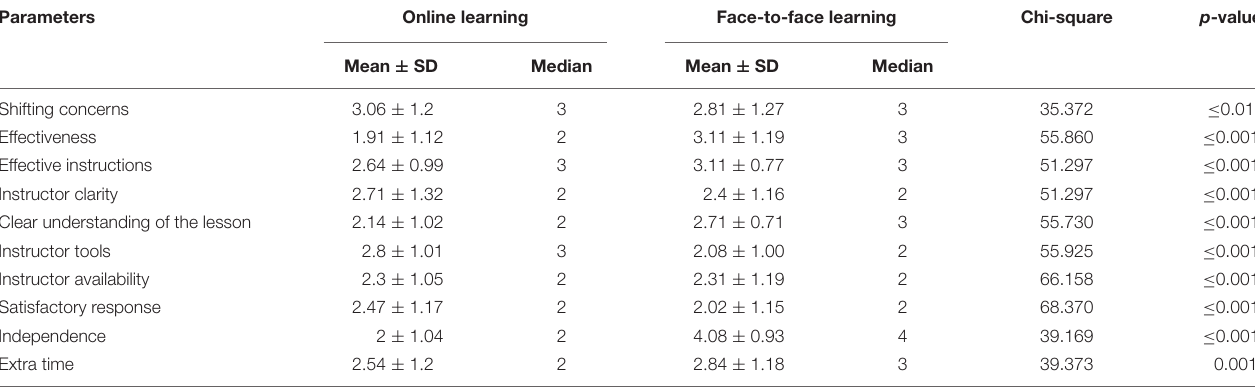
TABLE 3 | Comparison between online and face-to-face learning by various parameters.